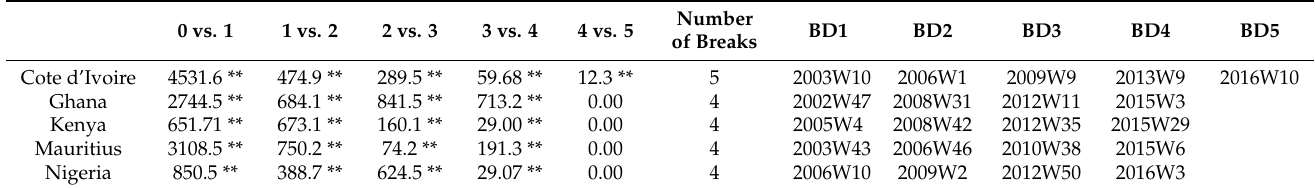
Table 6. Bai–Perron multiple-breakpoint tests.